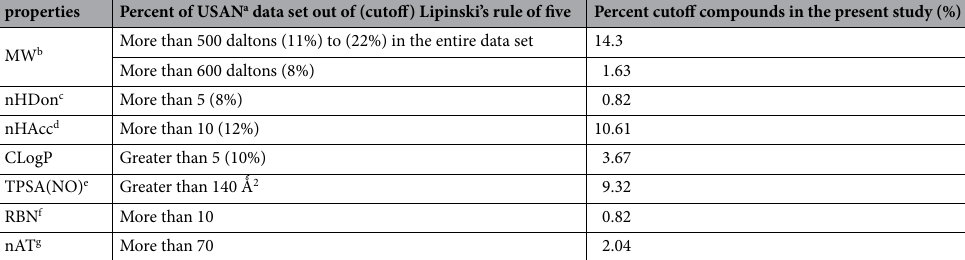
Table 1. Assessment of the drug-likeness (solubility and permeability of a molecule) based on Lipinski’s rule of five. a United States Adopted Name. b Molecular weight. c H-bond donors (Total NH and OH). d H-bond acceptors (The sum of nitrogen and oxygen atoms). e Polar surface area (only nitrogen and oxygen atoms considered). f Rotatable bonds number. g Number of